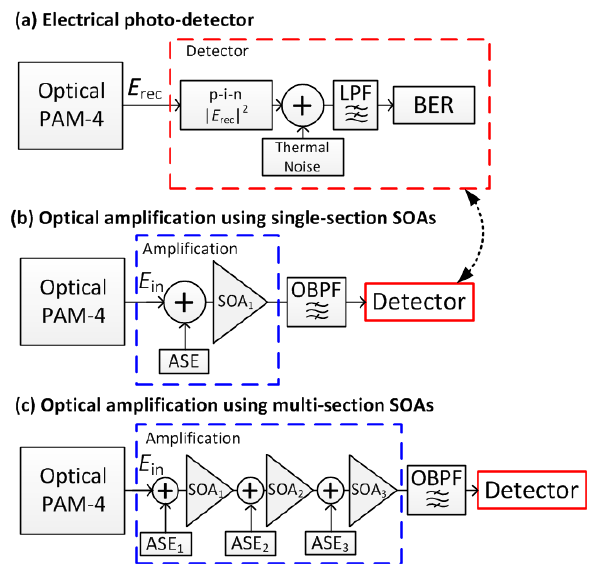
Figure 3. Simulation scenarios performed in this submission. ( a ) Linear receiver with PIN photodiode including thermal noise. LPF: Lowpass filter; ( b ) Pre-amplified PAM4 signal using an SOA. ASE is added before SOA, the receiver is as in ( a ); ( c ) multi-section SOA, the SOA is split into three separate SOA subsections, ASE noise is added before each SOA subsection. Adjusting the bias can alter the NF and saturation power of each subsection. The detector is as in ( a ).